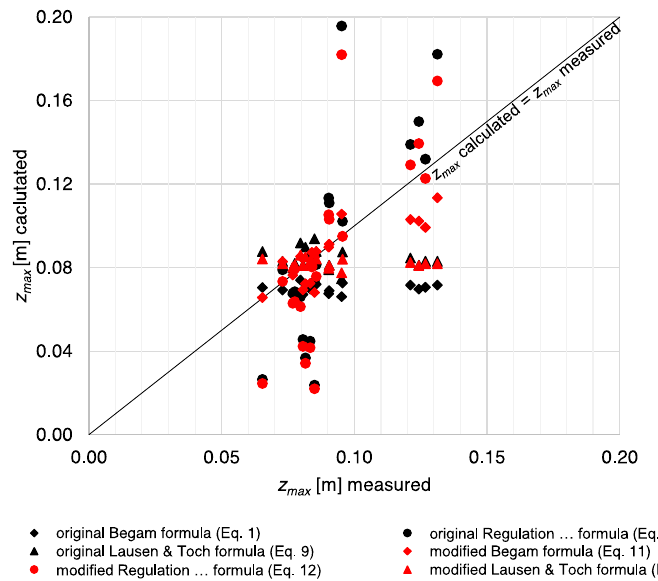
Figure 16. Calculations results using Begam formula (Equations (1) and (11)), Regulation of the Polish Minister formula (Equations (8) and (12)), Laursen & Toch formula (Equations (9) and (13)).